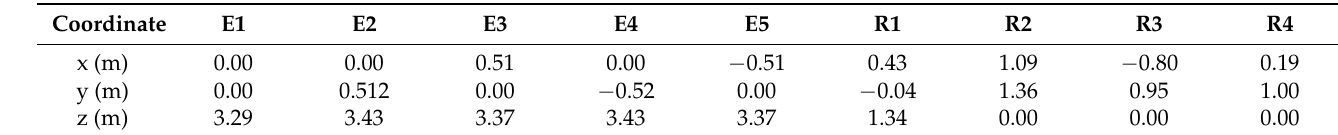
Table 2. Coordinates of the five beacons (E1–E5) and the four receivers (R1–R4) in the experimental environment of the CODEUS online demonstrator.